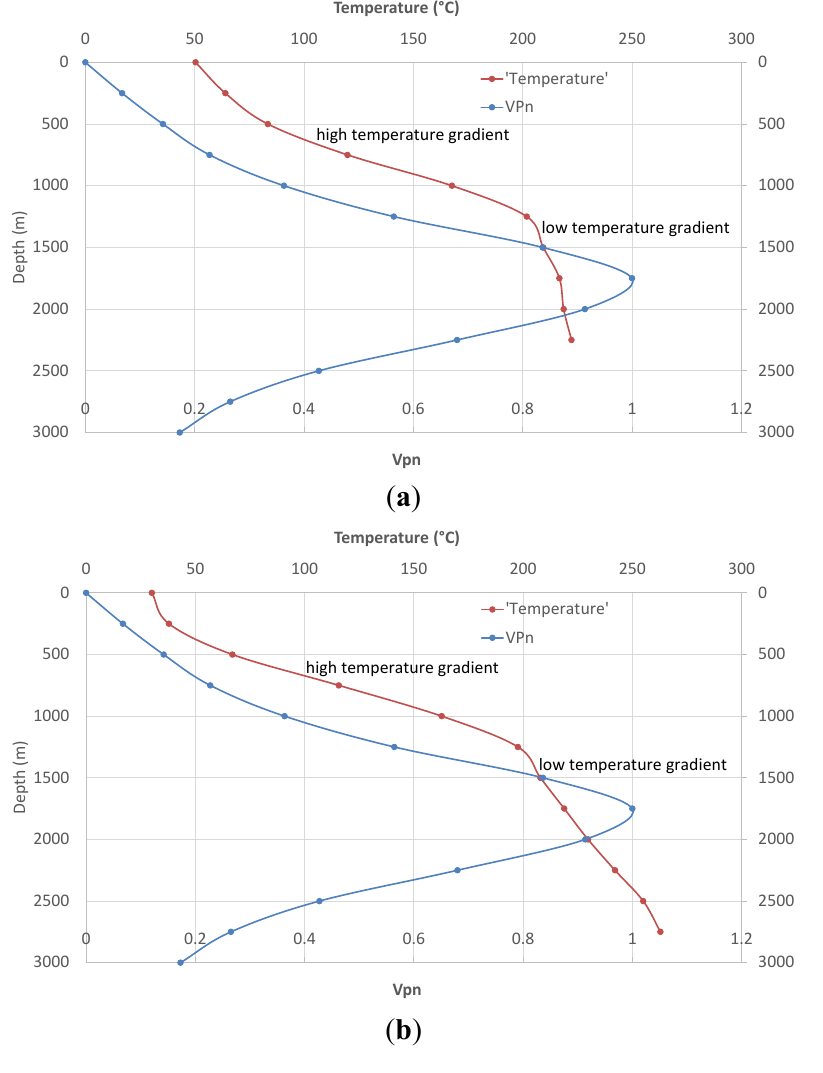
Figure 6. Plot showing variation in well temperature and variation in normalized seismic velocity anomaly ( V pn ) with depth as derived from the tomographic model of Shalev et al. [13]. The V pn values used are the average value for wells MON-1 and MON-2. ( a ) Values for well MON-1; ( b ) Values for